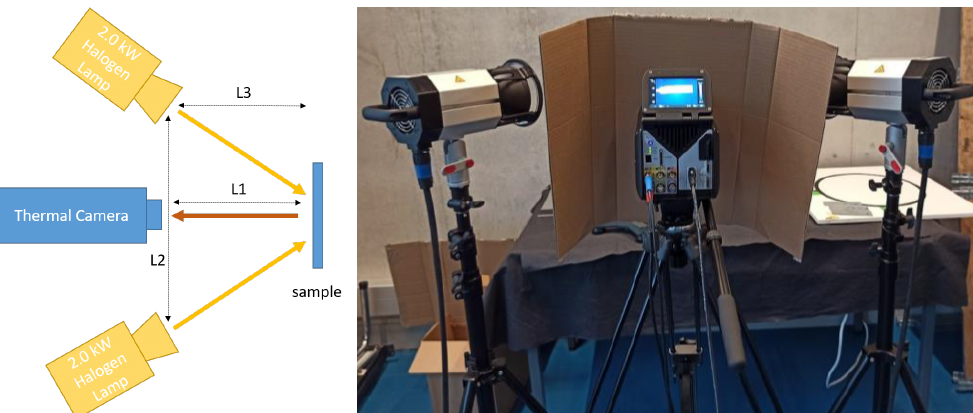
Figure 2. Visualization of the measurement setup used for light heating experiments. The left image is a schematic representation of the setup, and the right image is taken during measurements.